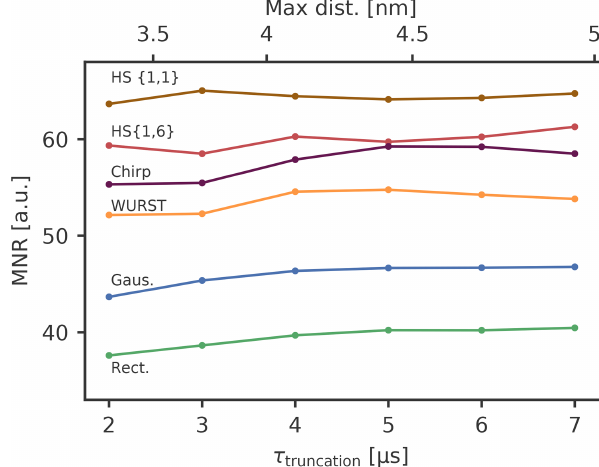
Figure 8. The MNR as a function of the dipolar evolution time up to which the noise has been evaluated. The sample has a concentra- tion of 30µM of the spin-labelled ligand. The maximum distance according to Eq. (13) is depicted in the upper x axis. The line be- tween the points is only a guide for the